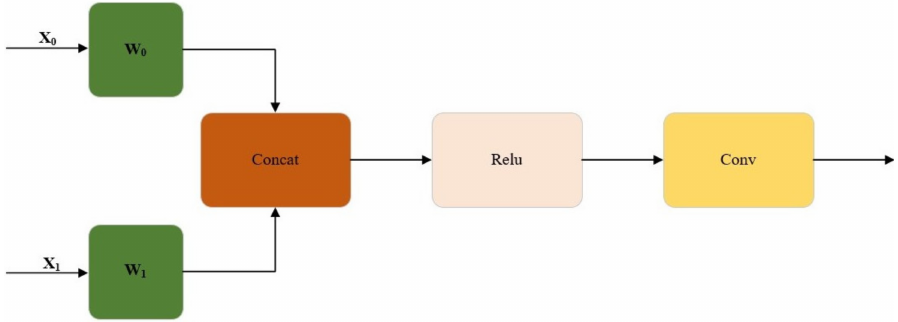
Figure 7. Overview of the WConcat splicing method. Feature maps x 0 and x 1 are spliced after W weight, then non-linearized with the Relu activation function, and then adjusted by